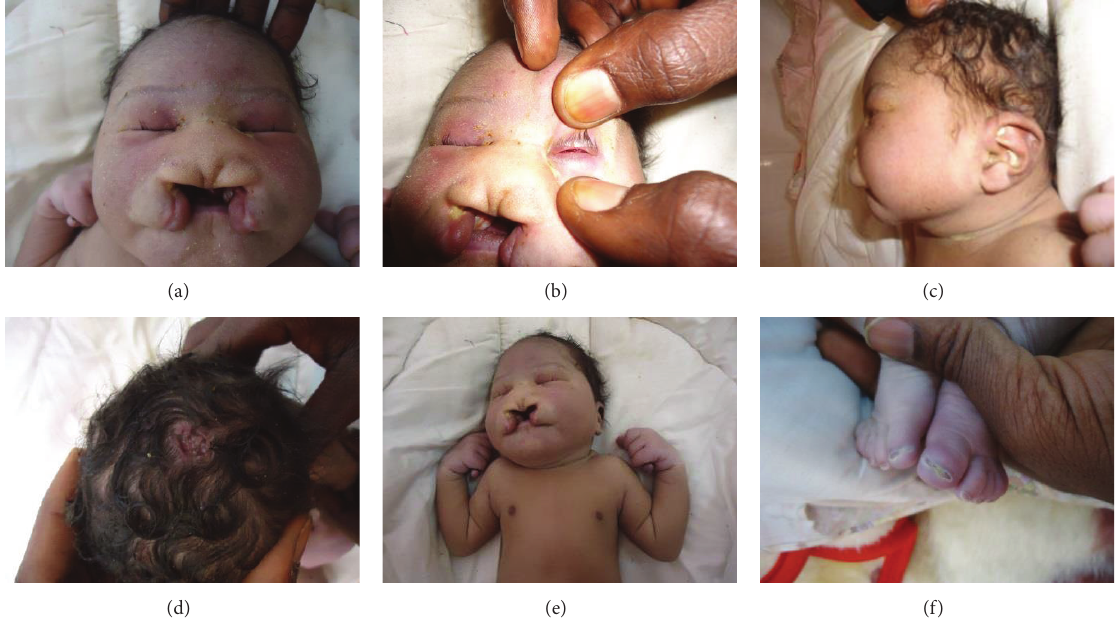
Figure 1: Craniofacial abnormalities observed in the patient. Note (a) median cleft lip and palate, (b) anophthalmia, (c) low-set ears, (d) aplasia cutis/scalp defect, (e) postaxial polydactyly on the hands, and (f) preaxial polydactyly of the